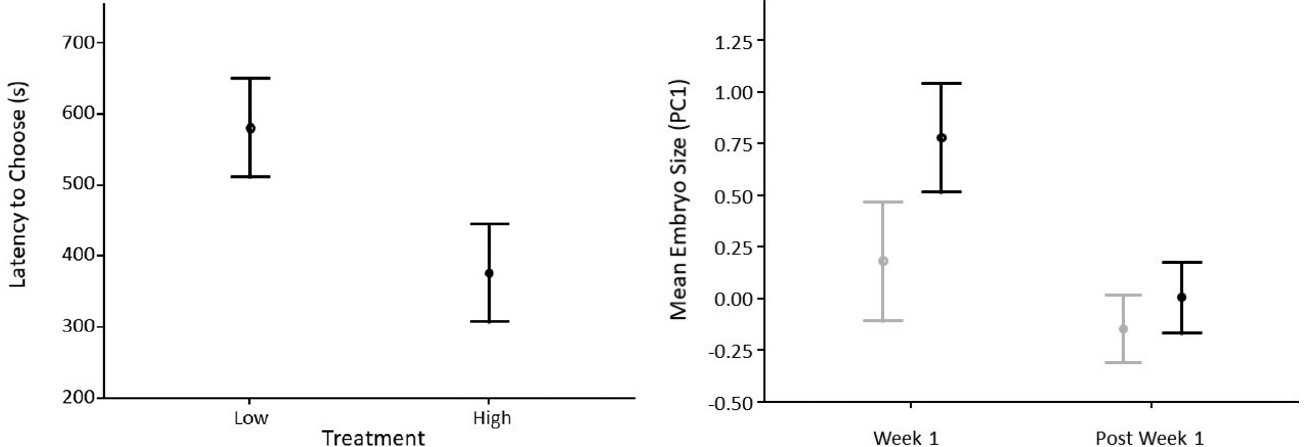
Fig. 1. Mean (±SE) latency of females to choose the speaker broad- casting either low- or high-quality calling song.